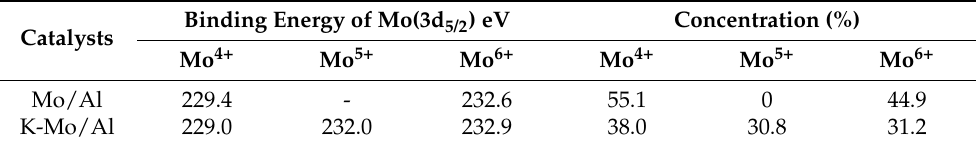
Figure 9. The fitting curves of Mo(3d) XPS spectra of ( a ) fresh Mo/Al, ( b ) fresh K-Mo/Al, ( c ) spent Mo/Al and ( d ) spent K-Mo/Al. Table 2. The fitting results of Mo(3d) XPS spectra of the spent catalysts.